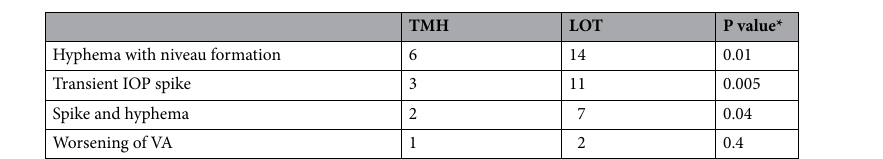
Table 3. Comparison of complication. IOP: intraocular pressure; VA: visual acuity. *Calculated using linear mixed model in complications between TMH and LOT.